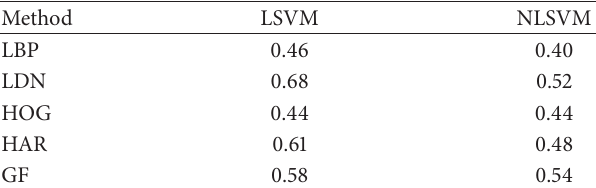
Table 6: Results of the greedy approach (AUC).